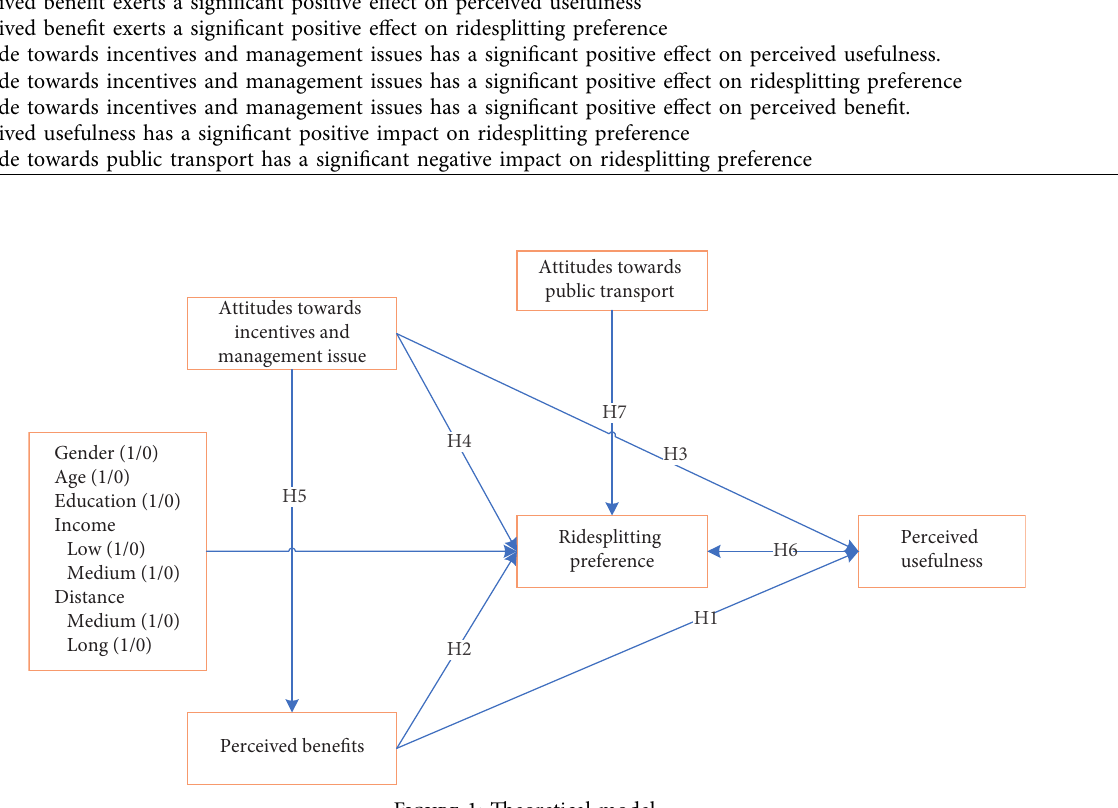
Figure 1: Theoretical